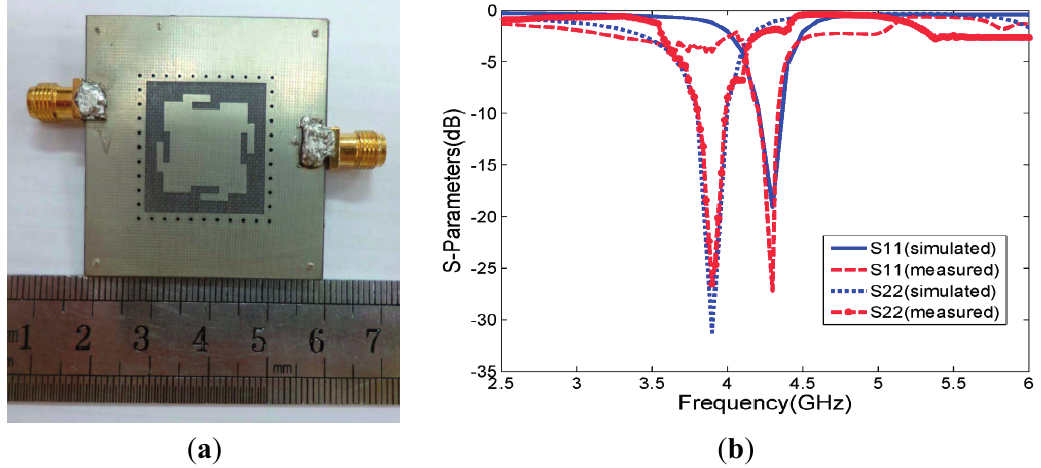
Figure 4. ( a ) Photograph of the proposed antenna; ( b ) Simulated and measured S11 and S22 of the proposed